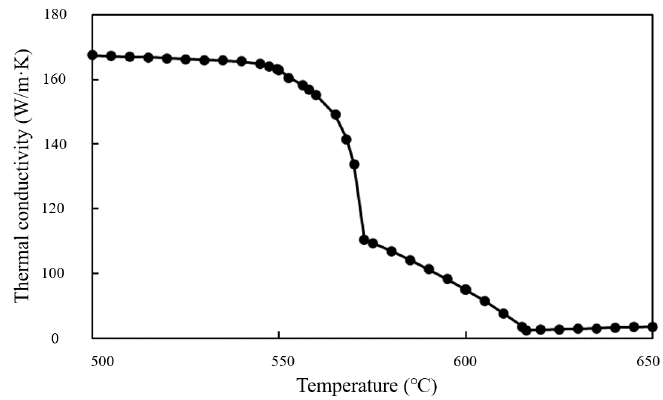
Figure 4. Thermal conductivity–temperature relationship diagram of Al–Si–Mg